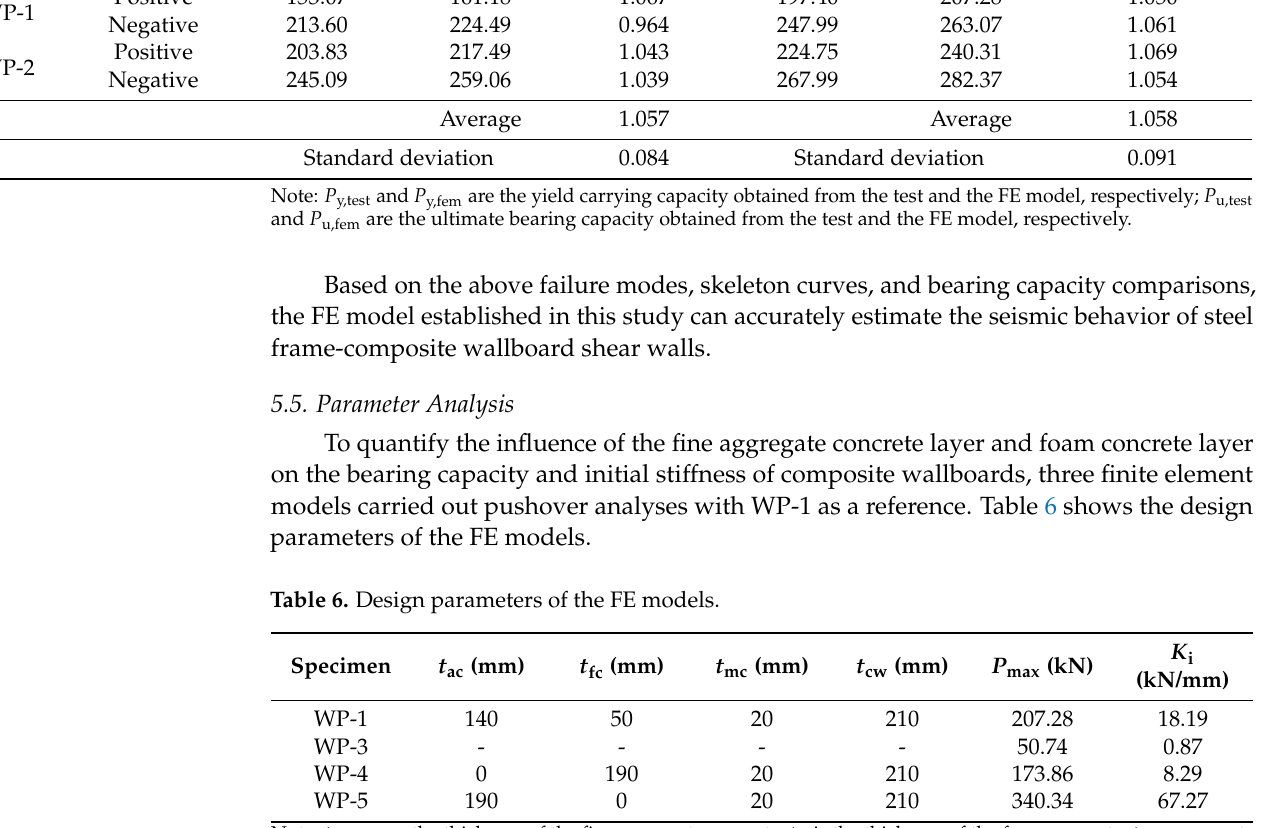
Table 6. Design parameters of the FE models.